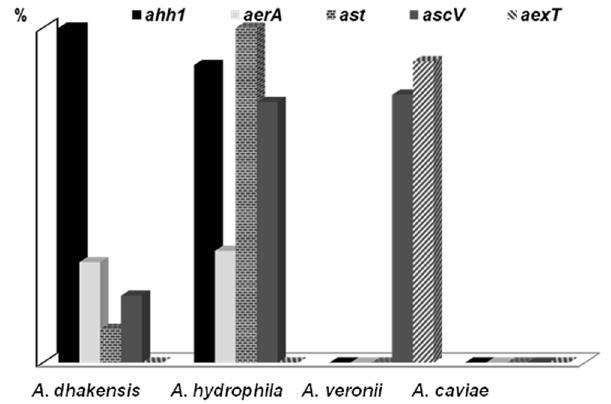
Figure 4. Distribution of putative virulence factors among blood isolates of four Aeromonas species: Aeromonasdhakensis (n=9), Aeromonas hydrophila (n=9), Aeromonas veronii (n=9), and Aeromonascaviae